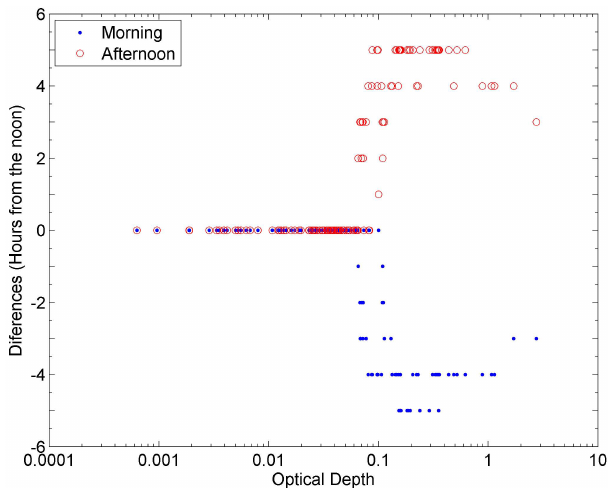
Fig. 2. Plot of the differences between hour of maximum SCRF and noontime (12:00LT) versus optical depth for the clouds measured with lidar in Camag¨uey. Threshold value is 0.083 for the occurrence of the maximum out of noon.